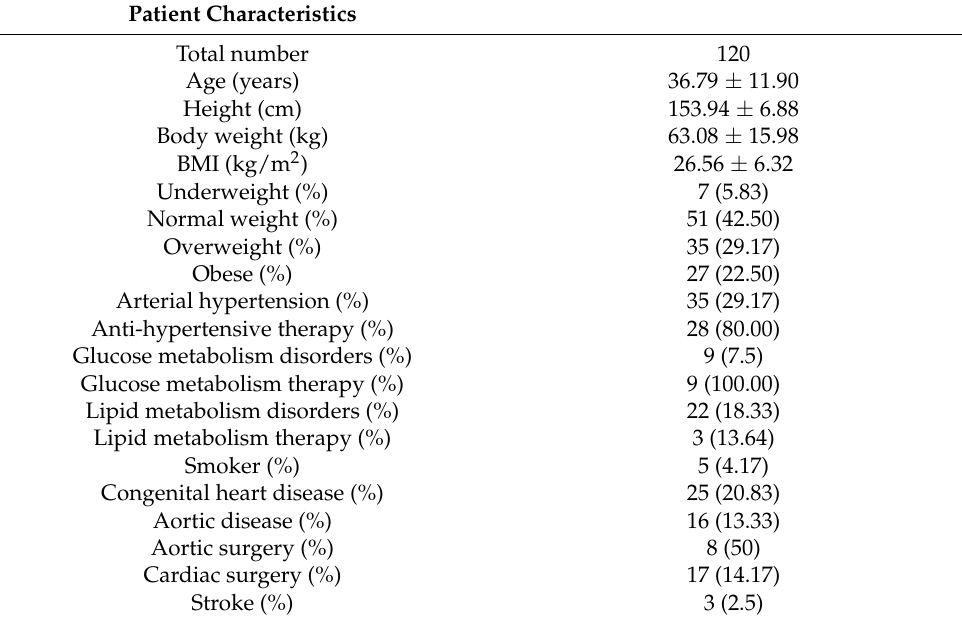
Table 1. Patient characteristics and cardiovascular morbidity of TS women in